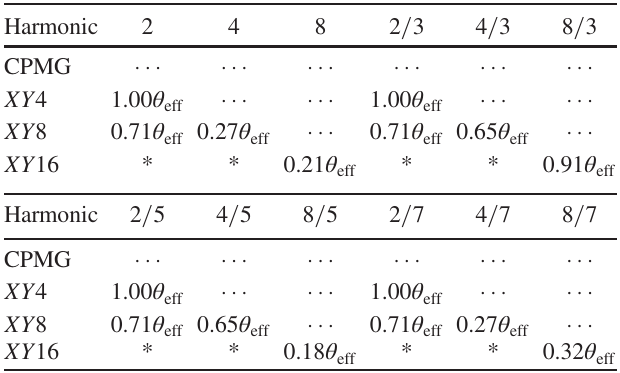
TABLE I. Anomalous phase ϕ π at harmonics f=f for CPMG, ac XY 4 , XY 8 , and XY 16 sequences (see Ref. [26] for sequence definition). Values were determined by a numerical simulation as ≈ Ω = ω described in Sec. IV. θ 1 is the angle of the effective eff field. Entries marked by * indicate that harmonics only appear in the presence of a static